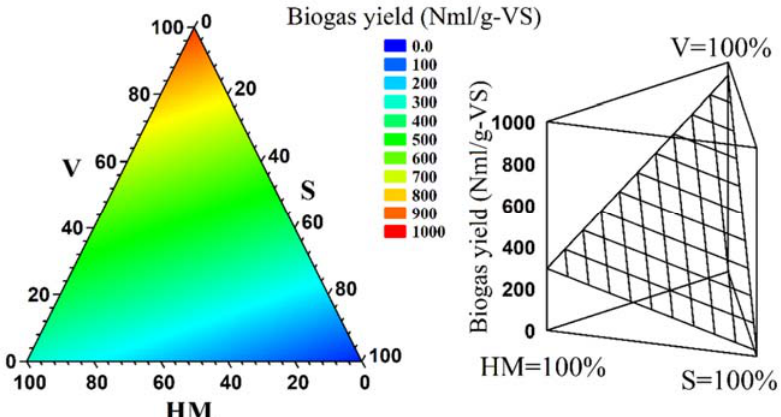
Fig. 4: The estimated biogas yield from substrate components